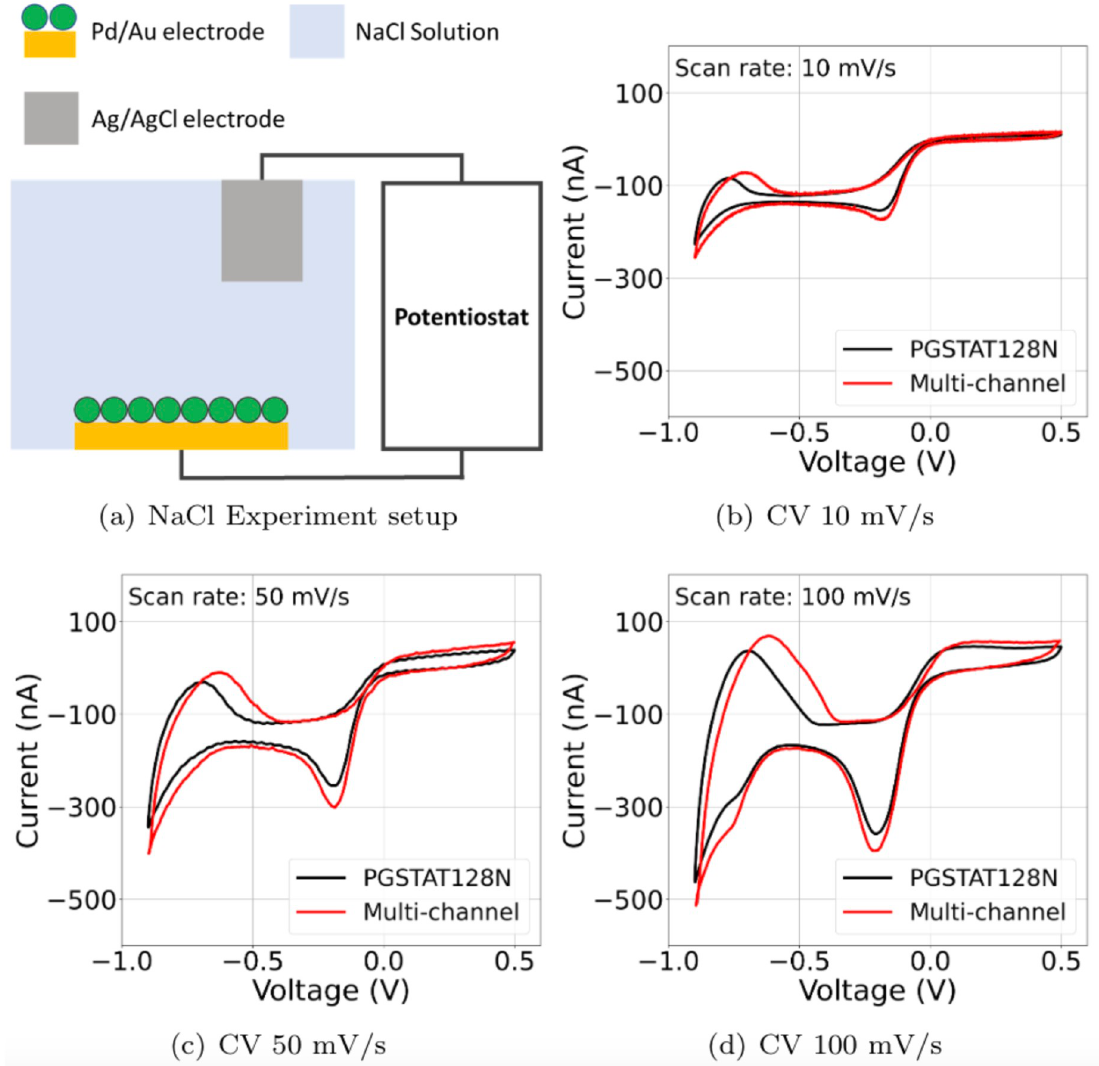
Fig 5. (A) Experimental CV setup with Pd functionalized Au electrode vs AgCl pellet electrode in NaCl solution. (B-D) CV of Pd NP/Au vs AgCl with various scan rates recorded with a commercial potentiostat and the multi-channel potentiostat device. (B) 10 mV/s scan rate (C) 50 mV/s scan rate (D) 100 mV/s scan